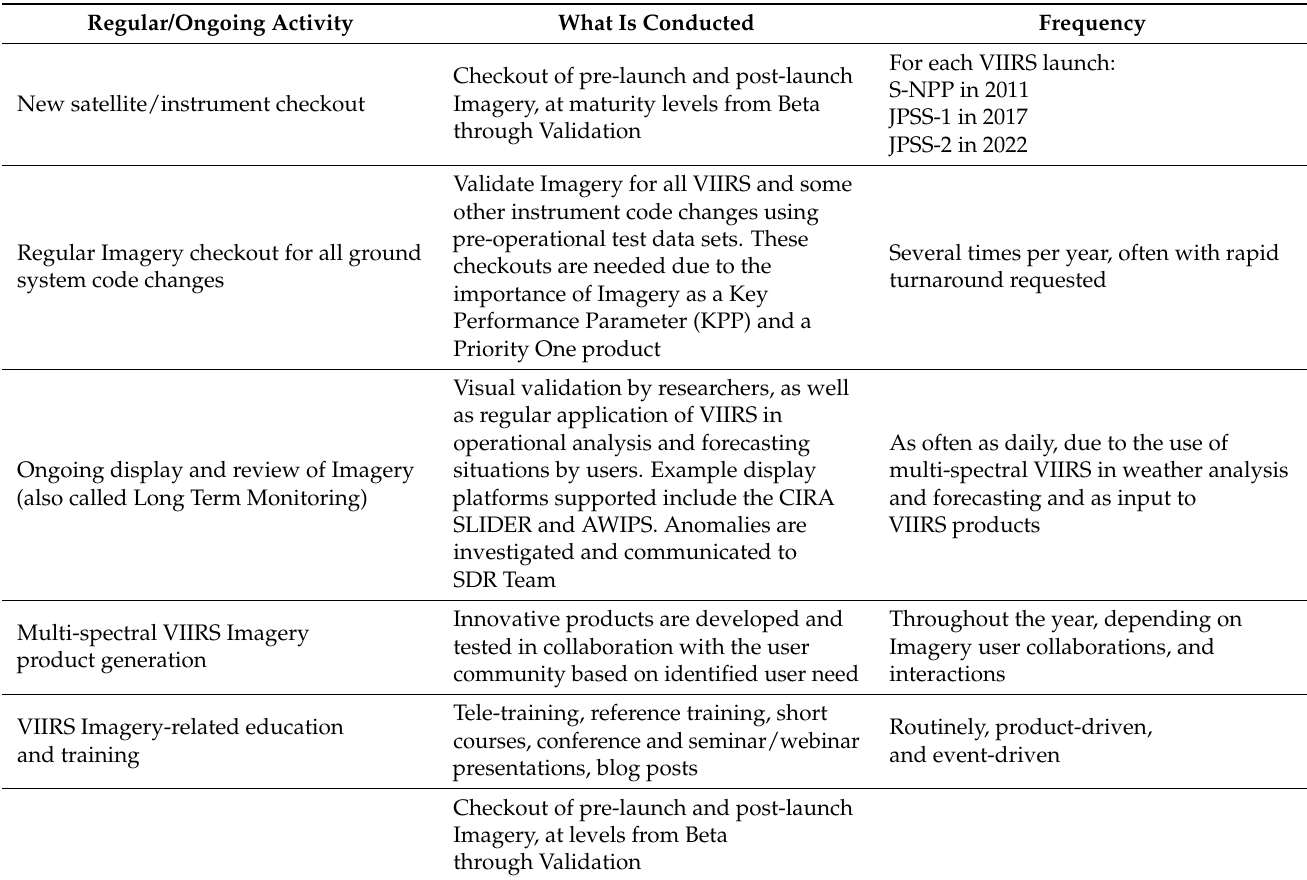
Table 1. Ongoing VIIRS EDR Imagery Team